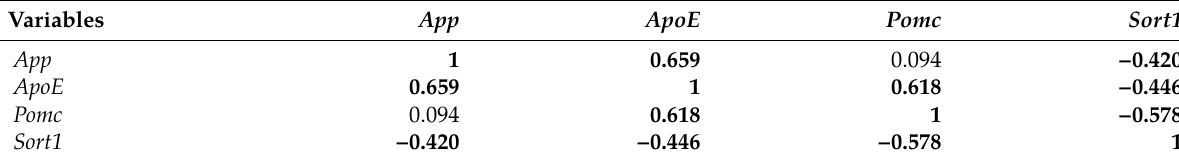
Table 5: Pairwise correlation of 4 genes based on 45 samples in our data. Variables App